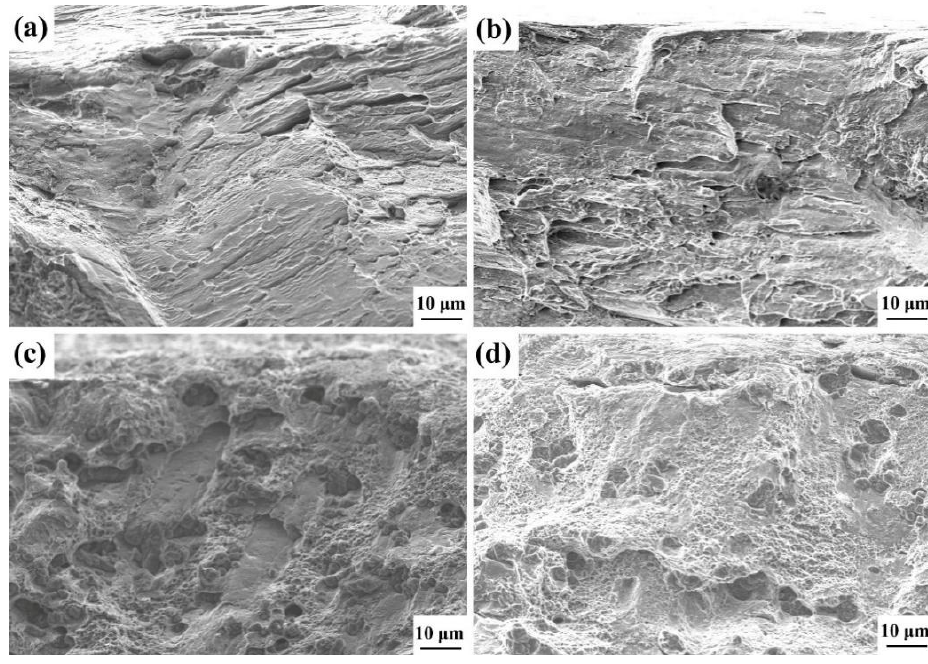
Figure 9. SEM images of the fractured surfaces of LAE361 Mg-Li alloy ( a , b ) and LA106 Mg-Li alloy ( c , d ) before and after the UNSM treatment.